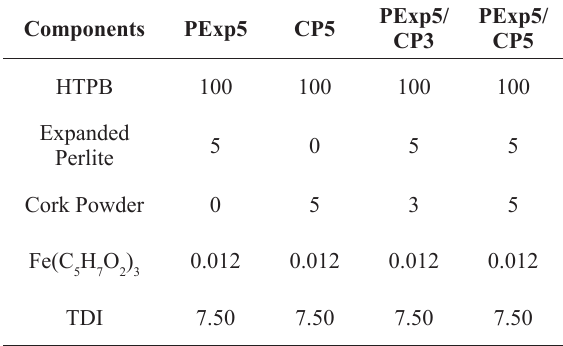
Formulations of PExp/CP